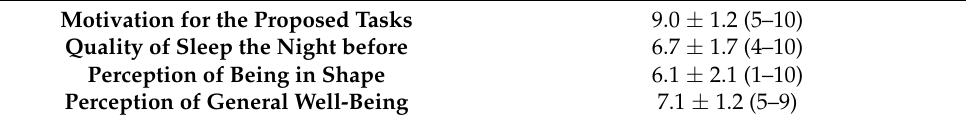
Table 2. Data on subjective markers of well-being a . Motivation for the Proposed